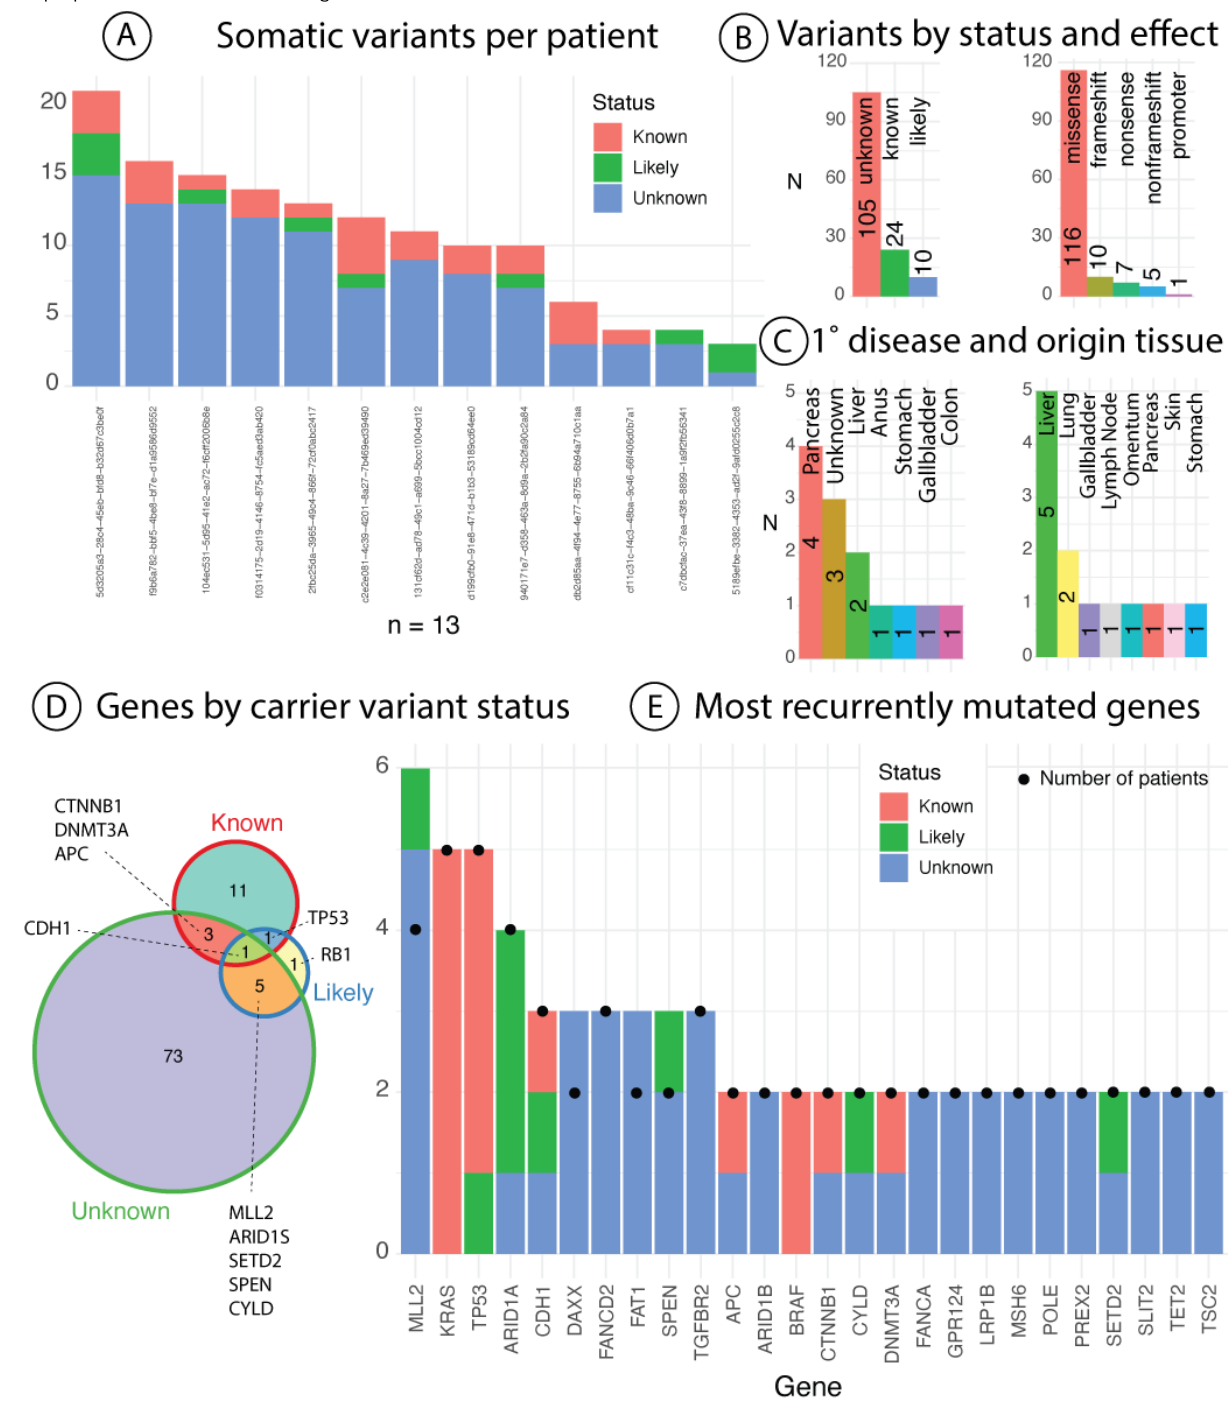
Figure 2. Breakdown of Foundation One genomics results for pilot cohort. (A) The breakdown of number of variants reported per patient stratified by their current knowledge status. (B) Breakdown of all variants for patients by effect (left) current knowledge status (right). (C) Distribution of cancer type per patient by primary disease (left) and tissue of origin (right). (D) Distribution of genes based on the current knowledge status of encompassed variants. (E) List of the most commonly recurrently mutated genes (N>1) by number of encompassed variants by status. Black dots represent number of unique patients with a variant in the